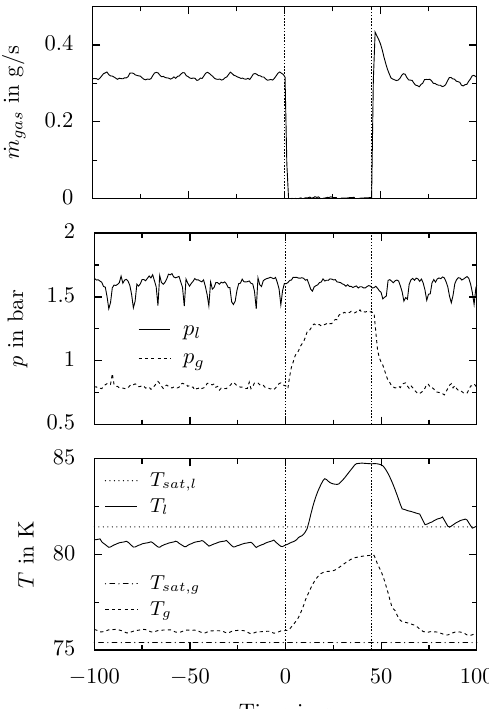
Figure 5. Temporal evolution of the mass flow to the vacuum pump, and the pressures and resulting temperatures in the liquid and gaseous domain inside the device handpiece during temporary disconnection of the vacuum pump from the outer tube starting at t = 0 . At time t = 45s the connection is re-established. The data for t < 0 and t ≥ 0 corresponds to the situation at the needle outlet, shown in Figs. 3 & 4, respectively. The dotted and dash-dotted horizontal lines in the lowest figure correspond to the saturation temperature related to the average pressures during stable operation, p l and p g , respectively 20